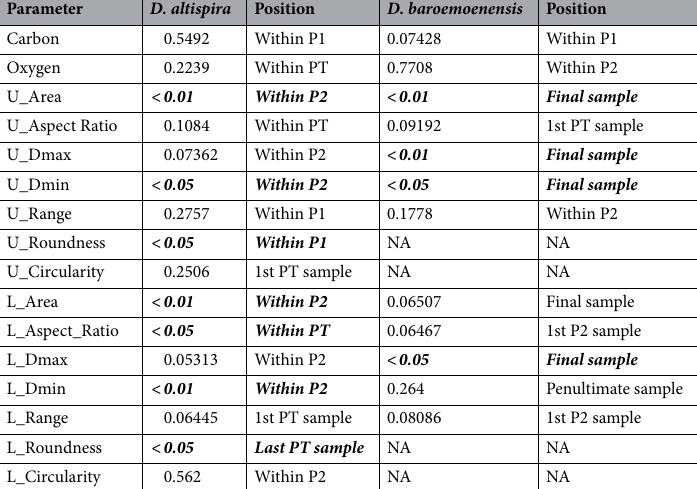
Table 1. Grubbs’ Test results. Bold and italic results indicate statistical significance (p < 0.05). U, Umbilical; L, Lateral; P1, Phase 1; P2, Phase 2; PT, Phase